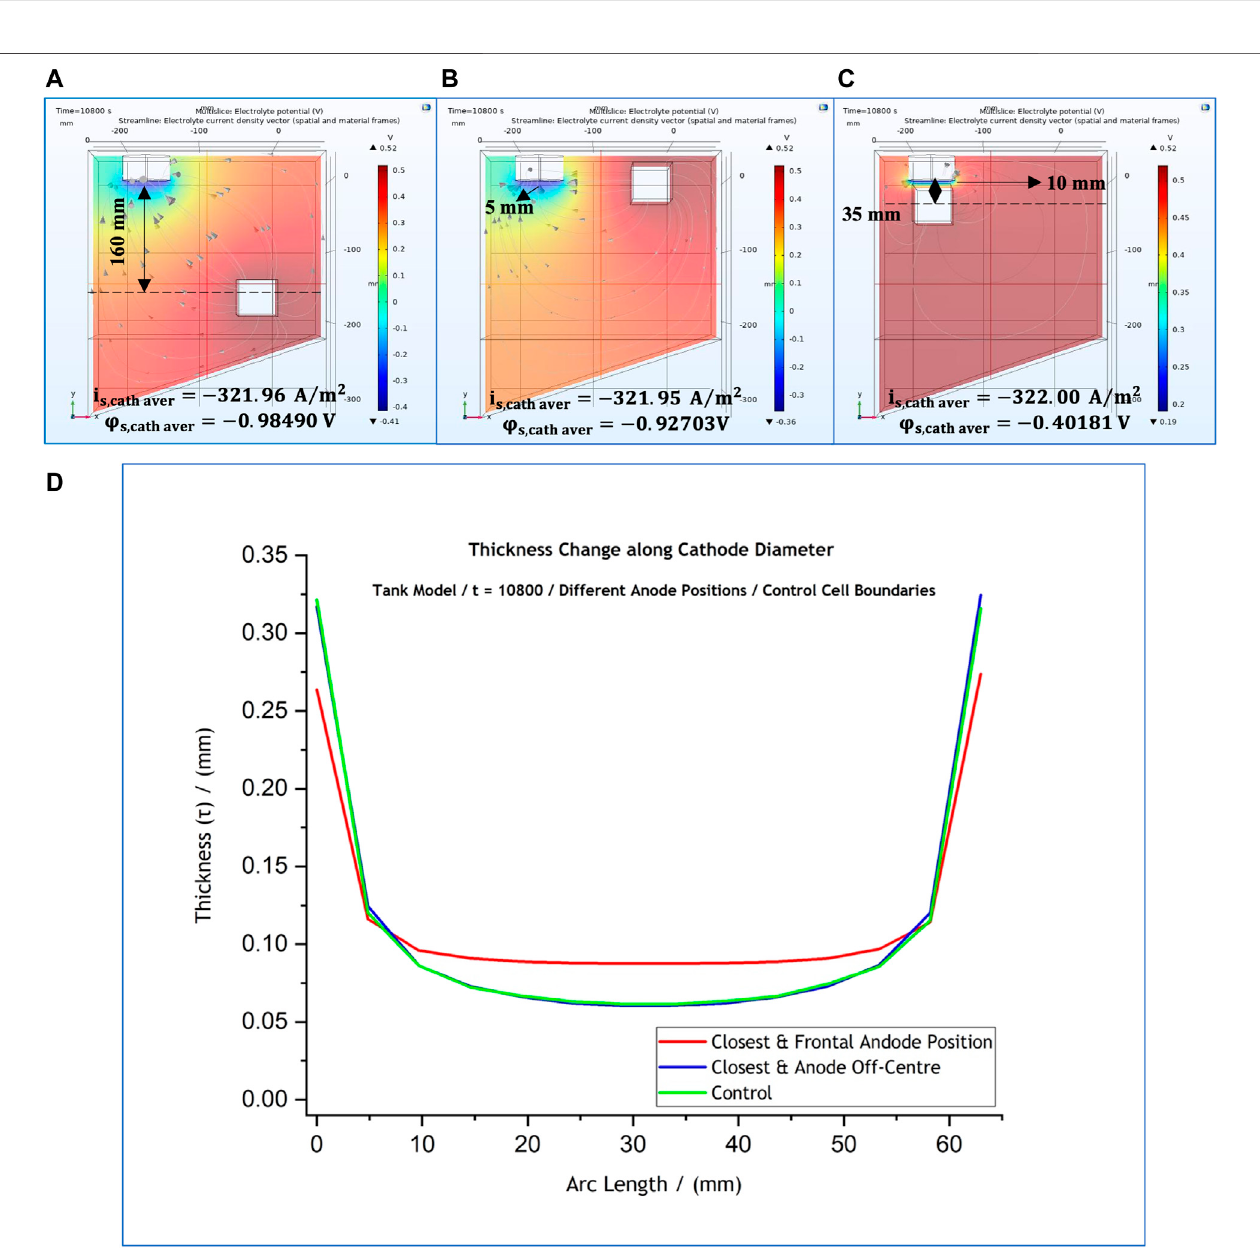
FIGURE10| anodeisplacedoff-centre,at (A) 25 mmand (B) 48 mmfromthecathodesurface.3-Drepresentationofthecurrentdistributiononthecathodesurfaceforthetwo cases when the anode is placed at (C) 25 mm and (D) 48 mm from the cathode surface. (E) Thickness pro fi les predicted for all anode positions. The results simulate potential and current distributions after 3 h at 50 ° C. Distances are provided with reference to the anode ’ s geometric centre.